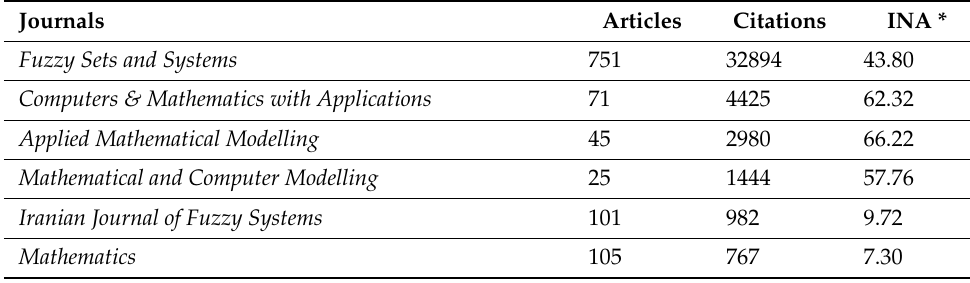
Table 3. High-impact journals.